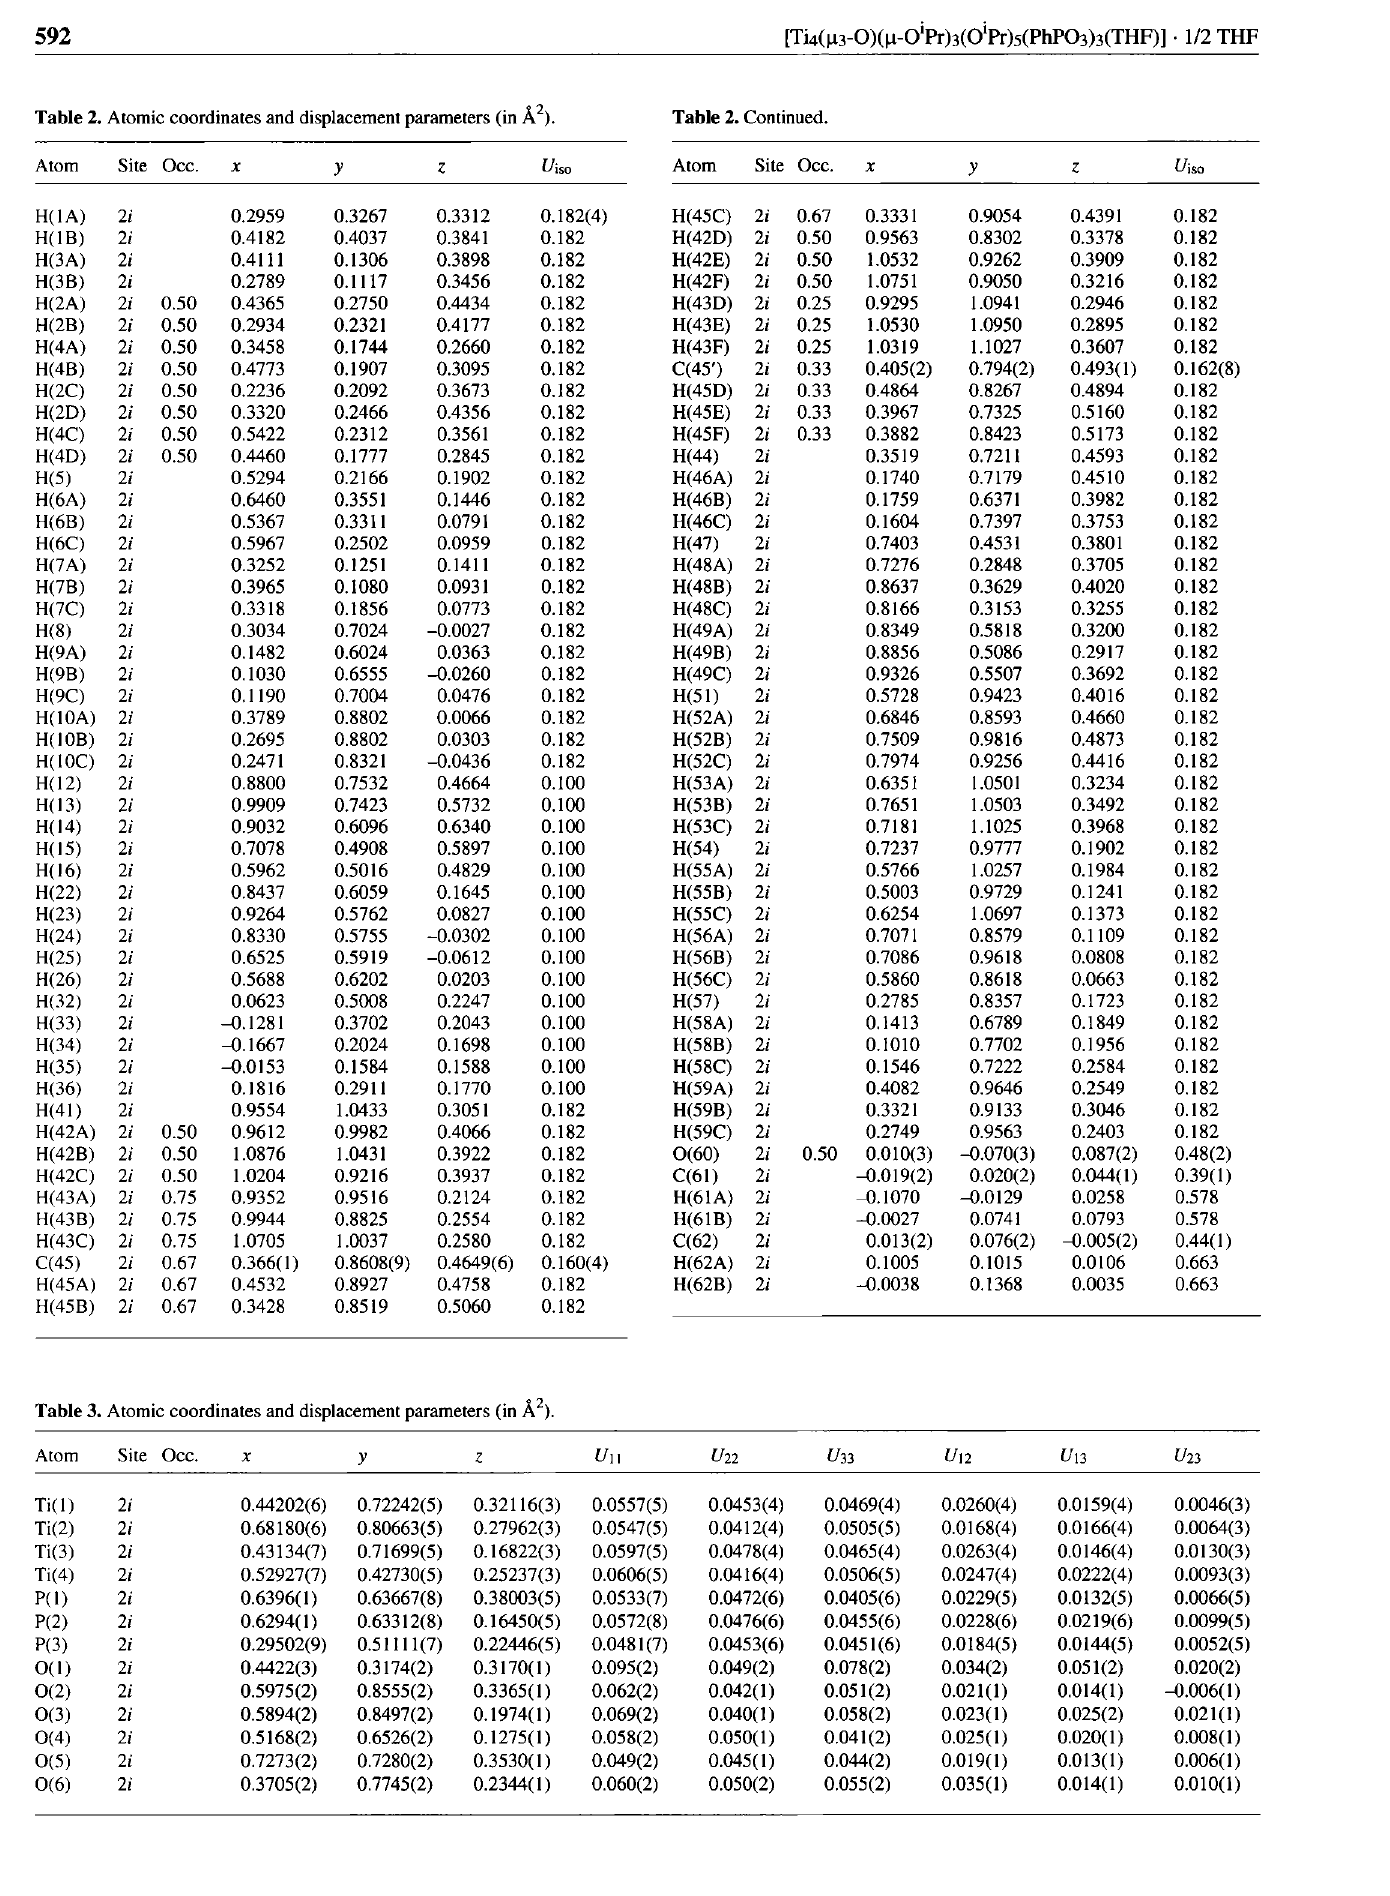
Table 2. Atomic coordinates and displacement parameters (in Ä 2 ). Atom Site Occ.